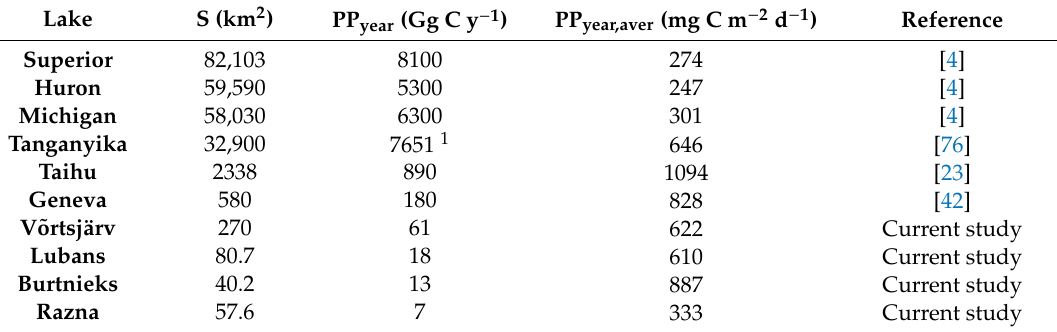
Table 2. The comparison of di ff erent lakes by their surface area (S, km 2 ), yearly total primary